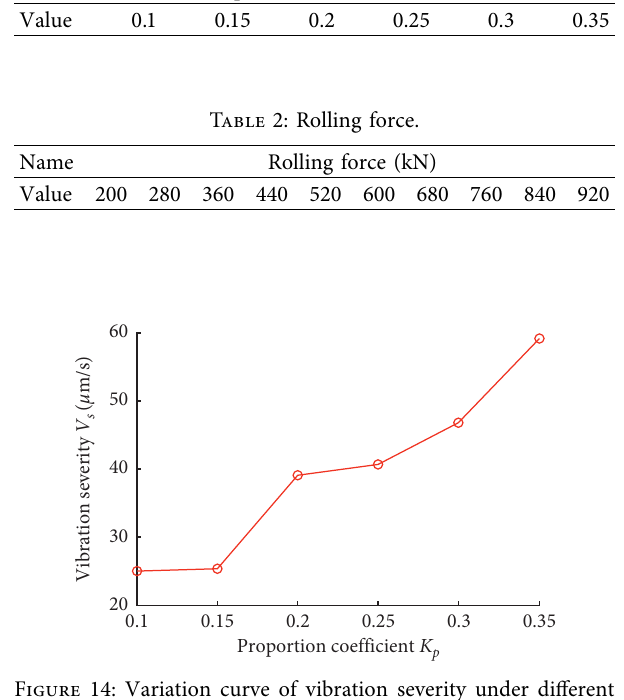
Table 1: Proportional coefficient of controller. Name Proportional coefficient of controller